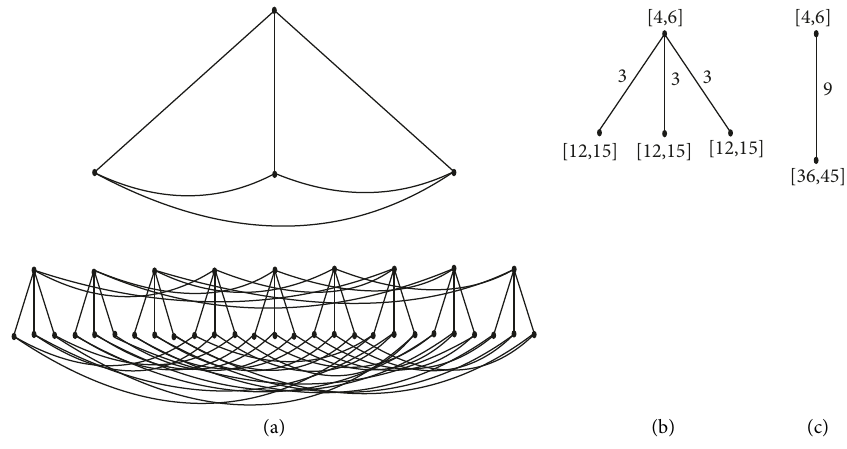
Figure 4: (a) THT ( 4 ) / F